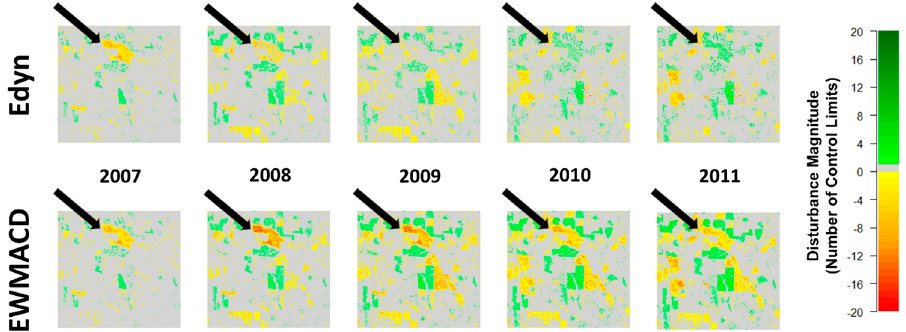
Figure 6. Edyn and EWMACD outputs for a subset of the study area in central Alabama, USA from Brooks et al., 2014 [5]. Note the north-central patch (indicated by the arrows) as an example of Edyn retraining reference curves.